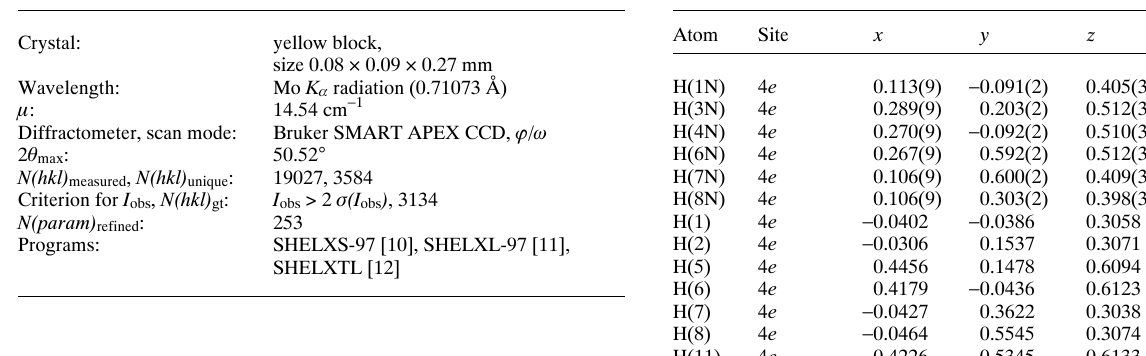
Table 2. A tomic coordin a tes a nd displ a cement p a r a meters (in Å 2 ) . Table 1. D a t a collection a nd h a